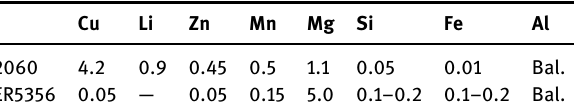
Table 2: Composition of the base metal Al – Li 2060 and ER5356 filler